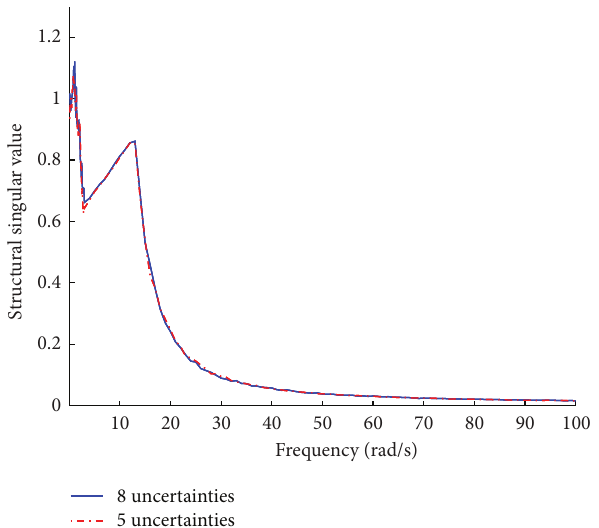
Figure 7: Structural singular value of the uncertain systems.